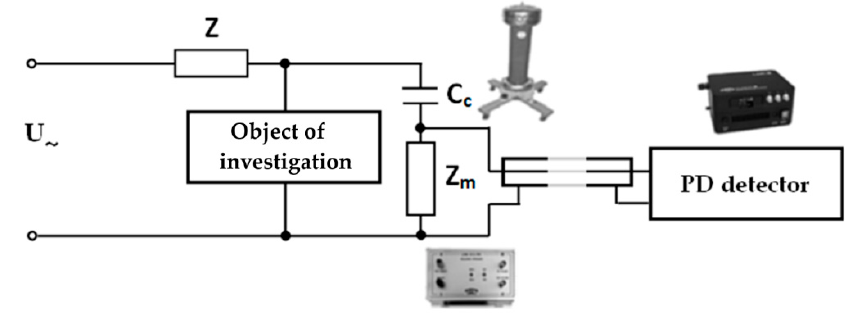
Figure 3. ( a ) Photograph of the test chamber; ( b ) Copper electrodes dimensions.